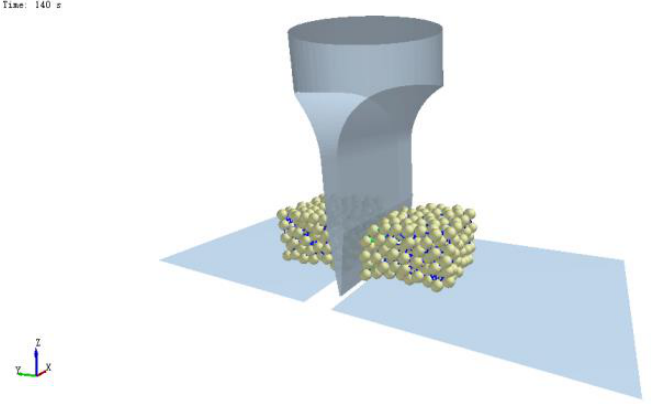
Figure 6. Discrete element simulation model of soil block shear crushing.